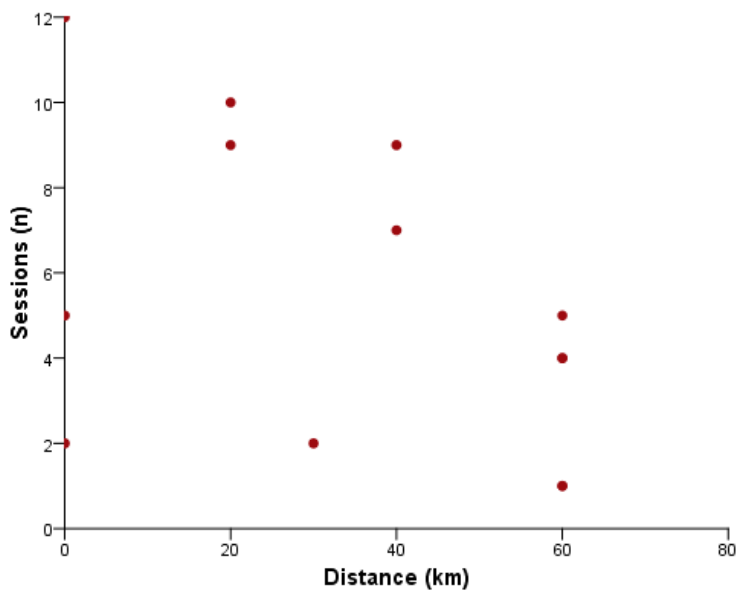
Figure 1. Scatter plot of Age vs. Sessions.